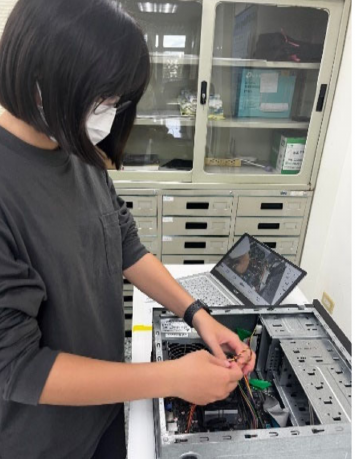
Figure 12. Job instruction via a video display.